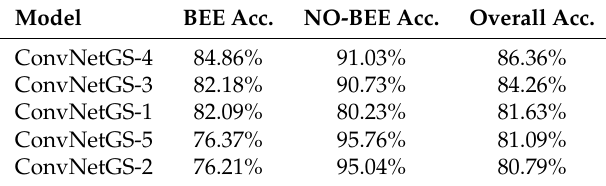
Table 4. Performance of five auto-designed ConvNets on BEE2_1S validation dataset. Each ConvNet was trained for 50 epochs. The number in the first column following the abbreviation ConvNetGS specifies the number of hidden layers; validation accuracies are sorted from highest to lowest. The architecture of ConvNetGS-4 is given in Figure A2 in Appendix A.